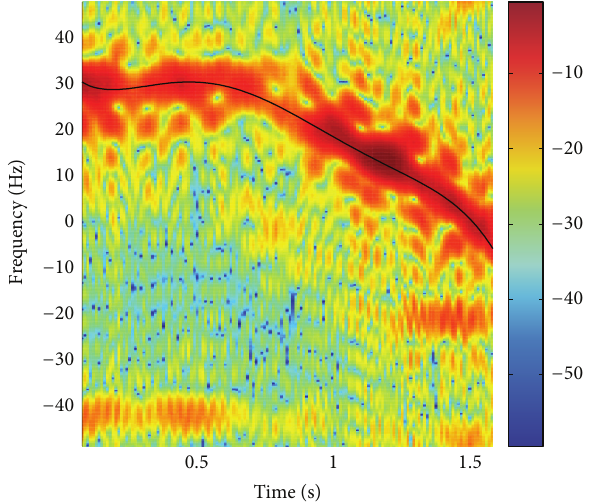
Figure 8: Doppler frequency trend determination from a series of spectrum snapshots of an isolated echo